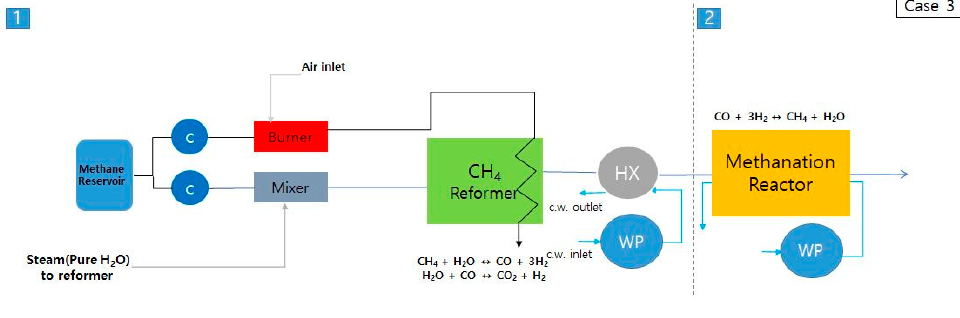
Figure 5. Schematic of ( a ) Case 2 reforming system and Graph of ( b ) molar flow and ( c1 , c2 ) molar fraction of outlet side.